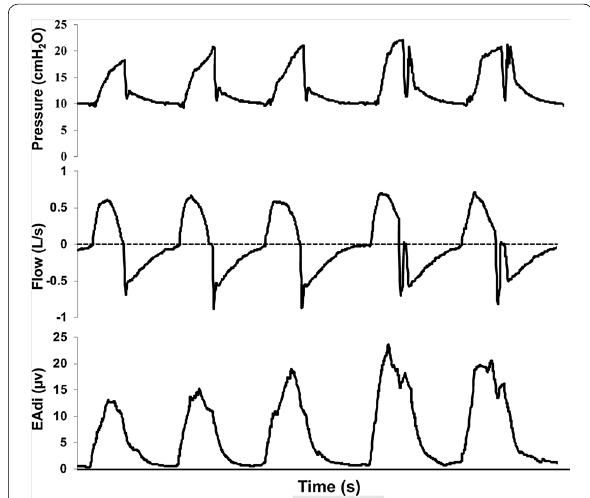
Fig. 3 Double triggering in NAVA. Pressure, flow and EAdi vs. time in a representative recording of a patient exhibiting double triggering in NAVA (visible in the last two respiratory cycles). The double triggering was related to EAdi signal showing a biphasic curve. Note that second cycle resulted in an increase in airway pressure, but had zero flow and did not result in breath stacking